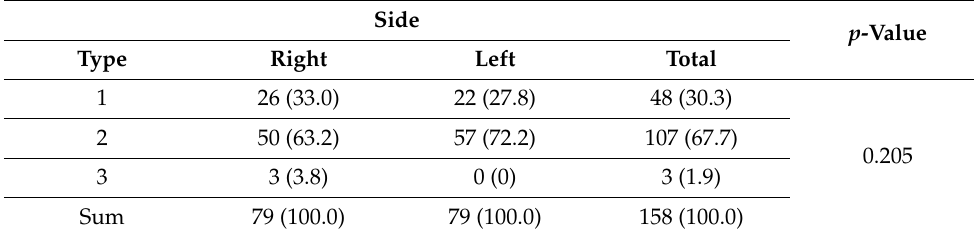
Table 2. Distribution of types according to the side ( n = 158).